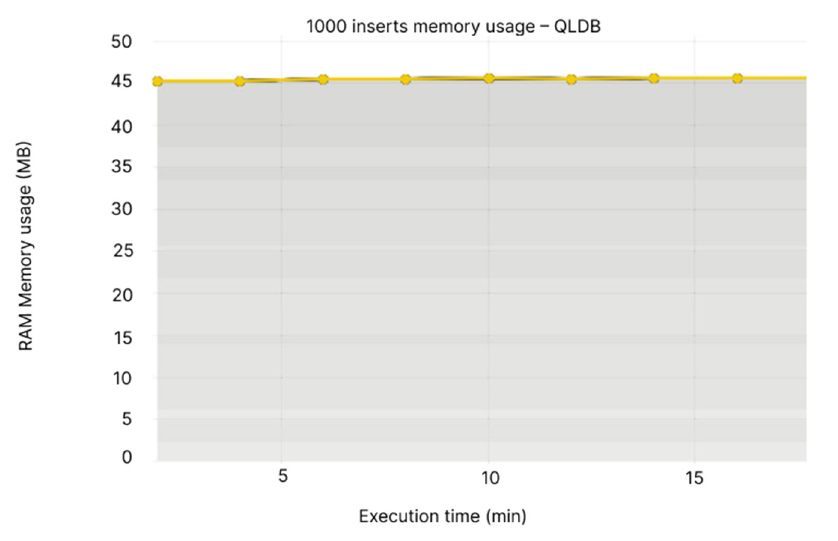
Figure 9. 1000 inserts memory usage—QLDB.